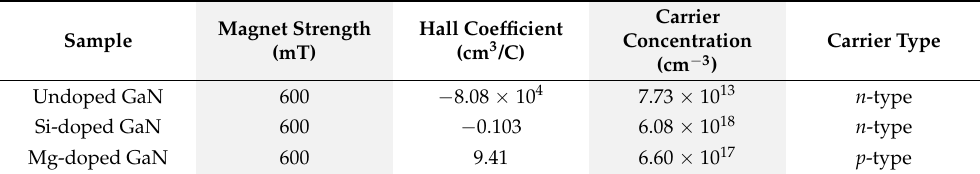
Table 2. Hall coefficient, carrier types, and concentrations in undoped, Si-doped, and Mg-doped GaN thin films.